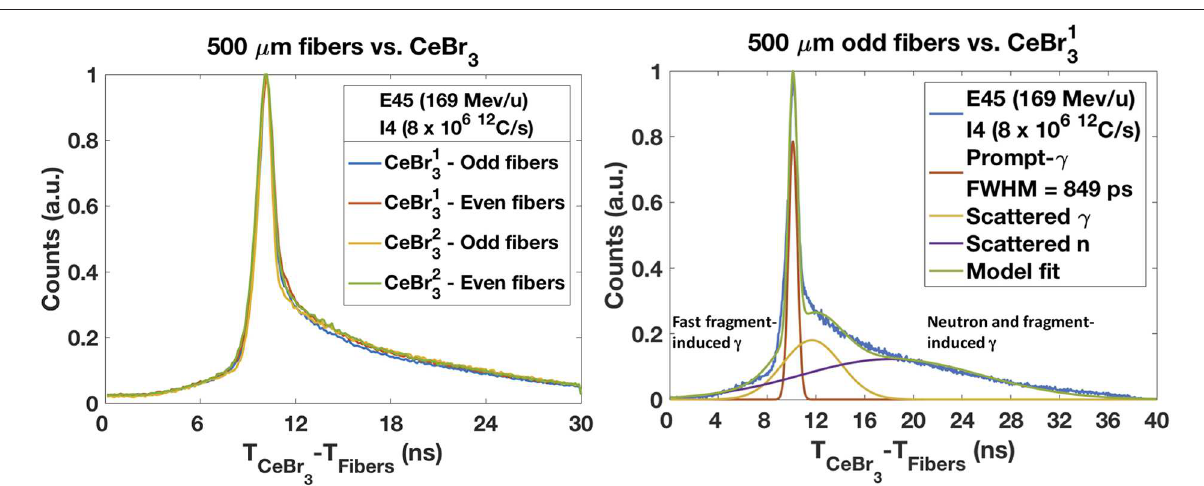
Frontiers in Physics | www.frontiersin.org